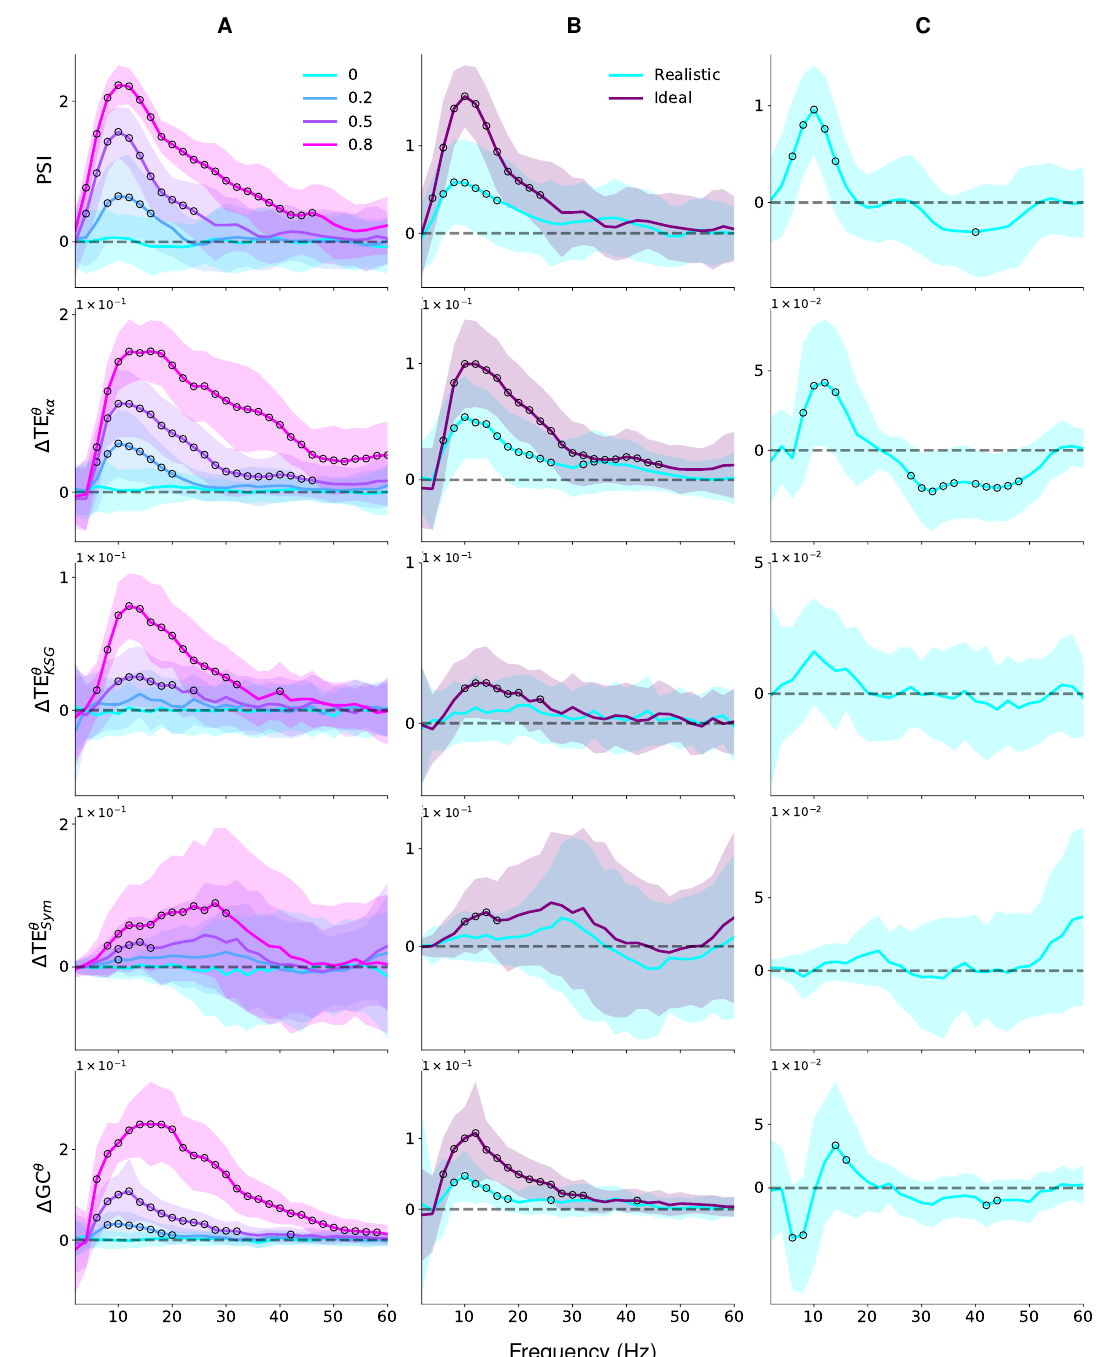
Figure 5. Obtained results for the experiments performed using simulated data from NMMs. Column ( A ) shows the average connectivity values obtained for different levels of coupling strength. Column ( B ) presents the average connectivity values estimated for ideal signals and for signals contaminated with noise and signal mixing. Column ( C ) displays the average connectivity values obtained for bidirectional narrowband couplings. The rows correspond to each of the net phase-based effective connectivity estimation approaches considered for the aforementioned experiments. Circled values indicate statistically significant results at a Bonferroni-corrected alpha level of 3.3 × 10 − 4 , according to a permutation test based on randomized surrogate